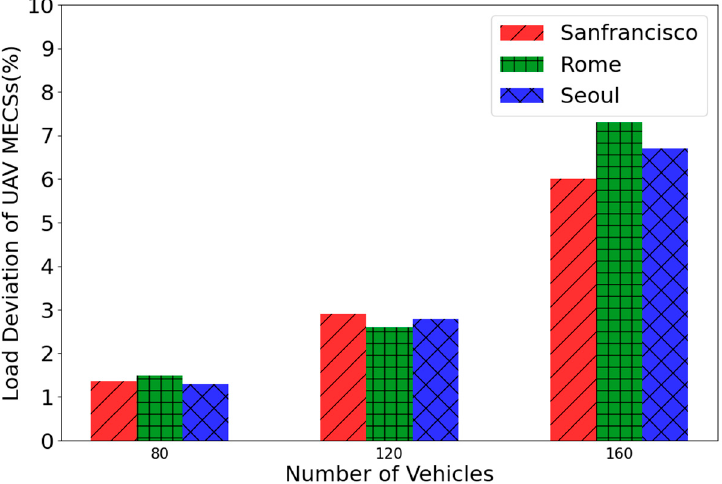
Figure 6. Load deviation of UAV MECSs with varying number of vehicles in different environments.